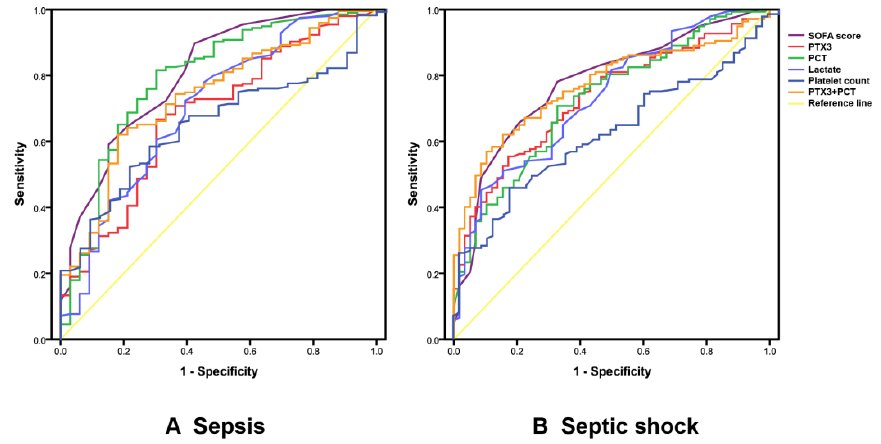
Figure 4. Receiver-operating characteristic (ROC) curves for diagnosing sepsis ( A ) and septic shock ( B ) by pentraxin-3 (PTX3), procalcitonin (PCT), lactate, and platelet